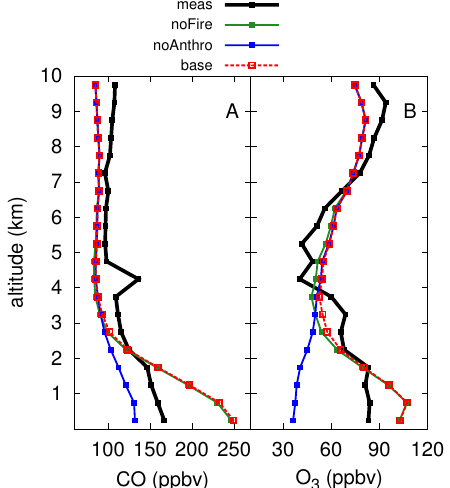
Fig. 5. Vertical profiles for MOZAIC flights over the northeastern United States compared to WRF-Chem results – measurements are in black, the model base run is in red, the noFire run is in green, and the noAnthro run is in blue. The comparison includes measurements onboard two commercial flights on 3 July.